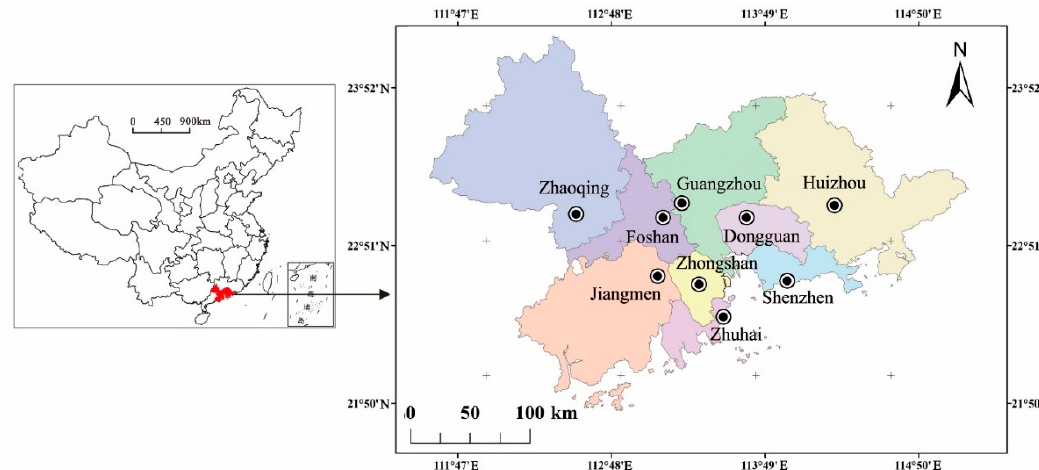
Energies 2019 , 12 , x FOR PEER REVIEW Figure 2. Location of the Pearl River Delta. Figure 2. Location of the Pearl River Delta.